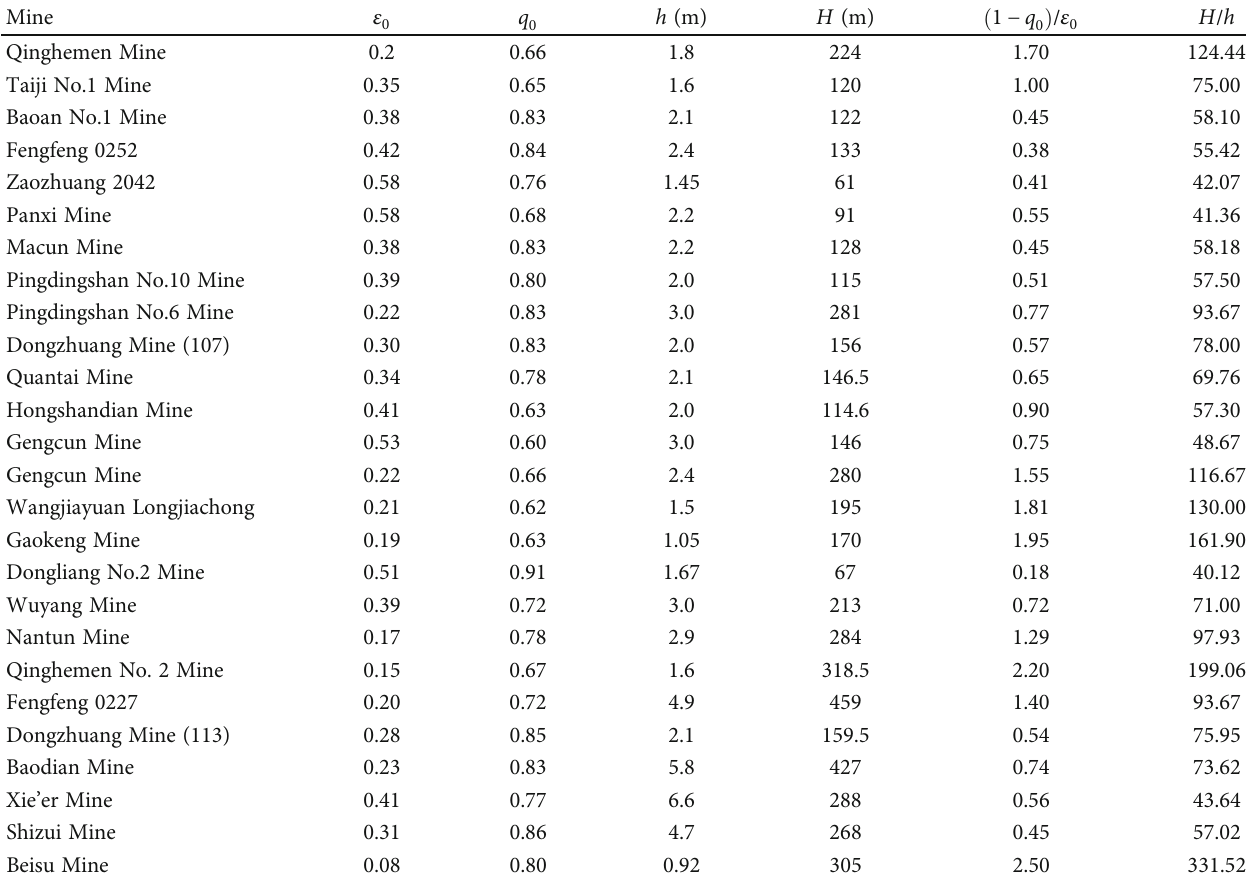
Table 1: Relevant parameters list of